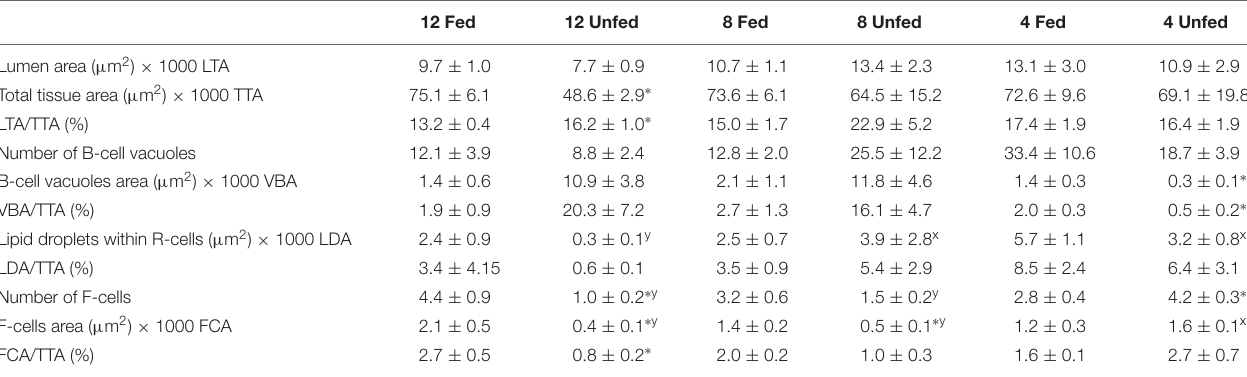
TABLE 8 | Morphometric parameters measured on the hepatopancreas histology preparations of H. gammarus fed and unfed kept at different holding temperatures (4, 8, and 12 ◦ C) after being held in captivity for 24 weeks. In total 12 tubules from each of n = 4 lobsters in each condition (=48 tubules/condition) were analyzed. 12 Fed 12 Unfed